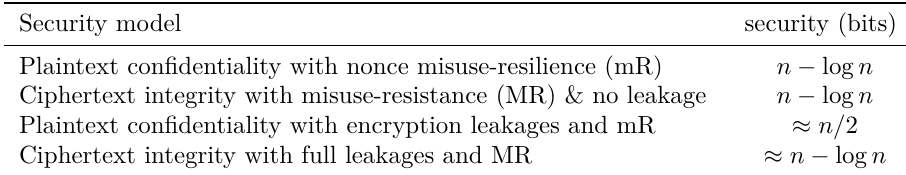
Table 2: Single-user security claims.